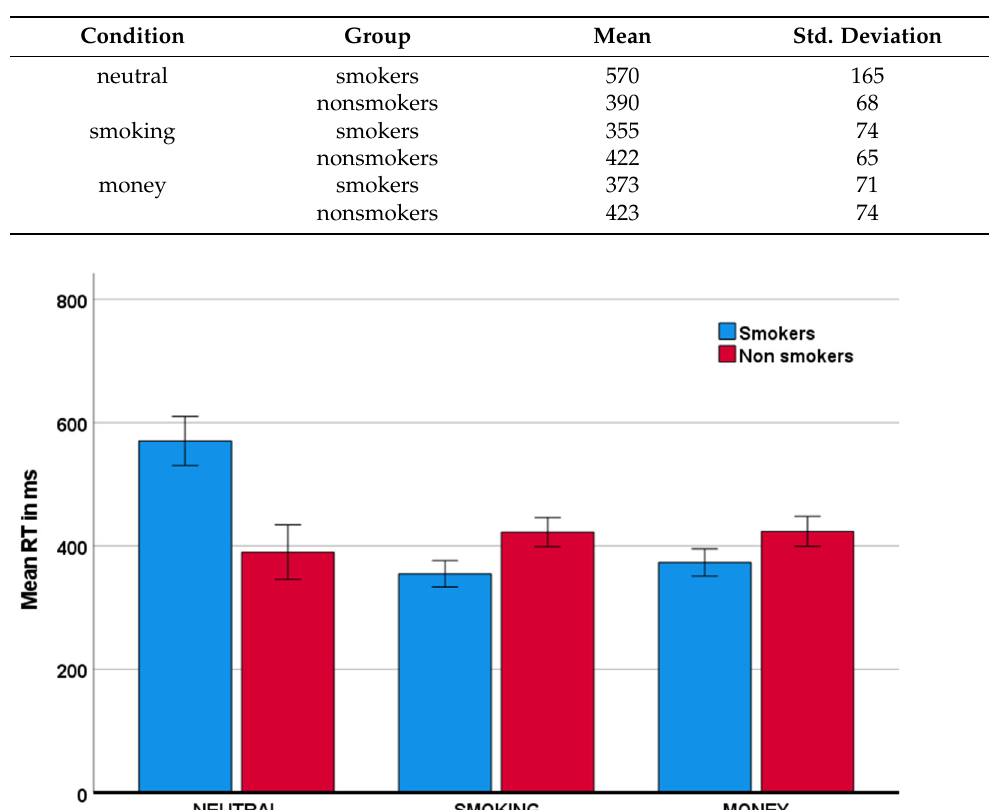
Table 2. Mean response time in milliseconds in go trials for smokers and nonsmokers in the neutral, smoking, and money conditions.